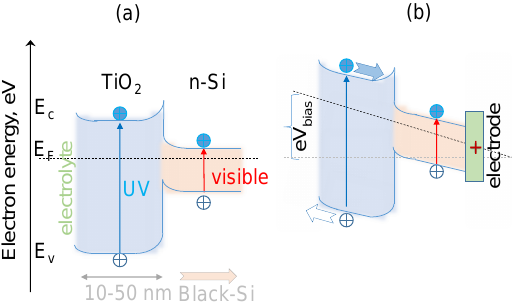
Figure 4. Potentiostatic scan at 1.23 V vs. RHE for the b-Si photoanodes fabricated for ( a ) 10, ( b ) 20 and ( c ) 40 min and coated with 10, 25, or 50 nm TiO 2 , respectively, in NaOH electrolyte under chopped light illumination.